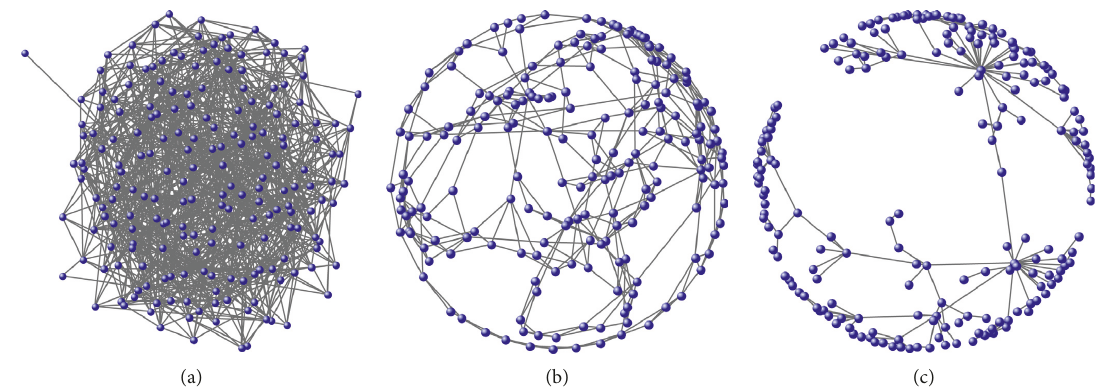
Figure 4: Random networks generated using the Erd¨os–R´enyi model (a), the Watts–Strogatz model (b), and the Barab´asi–Albert model (c).